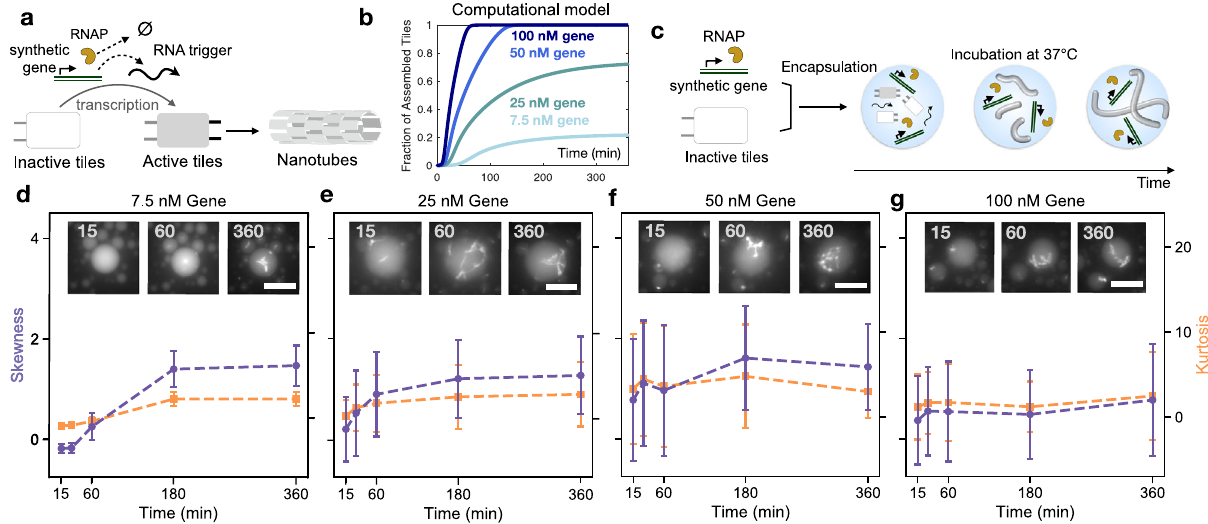
Fig. 5 Co-transcriptional isothermal assembly of encapsulated hybrid DNA-RNA nanotubes with in situ trigger transcription at 37 °C. a Inactive tiles are activated by an RNA trigger transcribed using a synthetic gene and subsequently assemble into nanotubes. b A computational model illustrates that by increasing the concentration of synthetic gene template, we can speed up the assembly kinetics and increase the equilibrium fraction of assembled tiles (modeling details in Supplementary Note S6.2). Increasing amounts of gene template are represented with darker shades of blue. c Inactive tiles at 500 nM concentration were encapsulated with transcription mix, 2.5% w/v PEG, and 2.5% v/v RNAP and incubated at 37 °C. d – g Representative fl uorescence microscopy images of droplet samples in which we titrated the amount of synthetic gene transcribing RNA trigger (insets) with plots of mean skewness (purple) and kurtosis (orange) for sampled droplets. The rate of increase of skewness and kurtosis correlates with the concentration of DNA template producing the trigger RNA strand. Data were presented as mean values ± standard deviation. Images were processed using the droplet detection code as described in Supplementary Note S4.13. The number of droplets sampled and a histogram data of radii for sampled droplets are reported in Supplementary Note S5.9 and S5.10. Source data for this fi gure is provided as a source data fi le. Scale bars: 20 μ